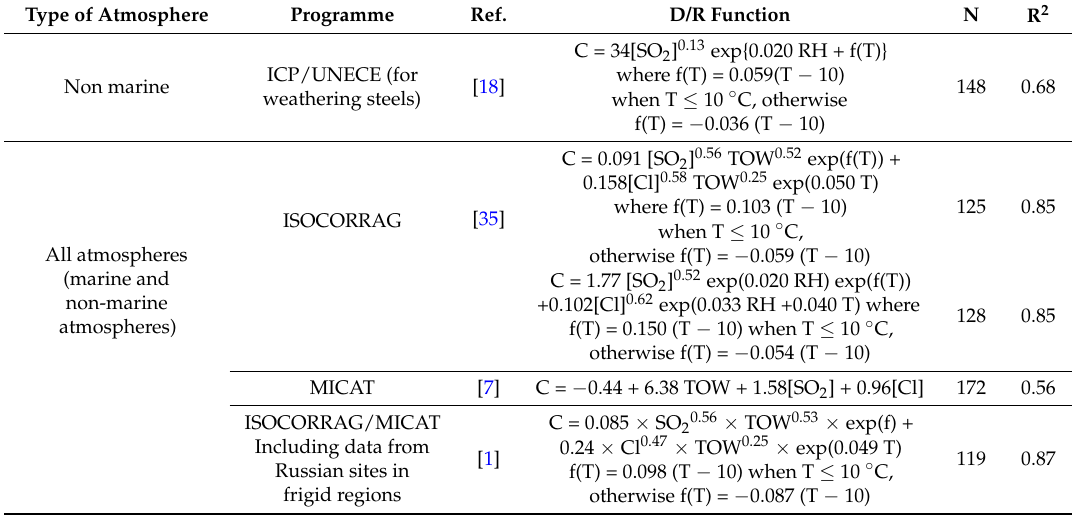
Table 8. Published dose/response (D/R) functions for first-year corrosion of carbon